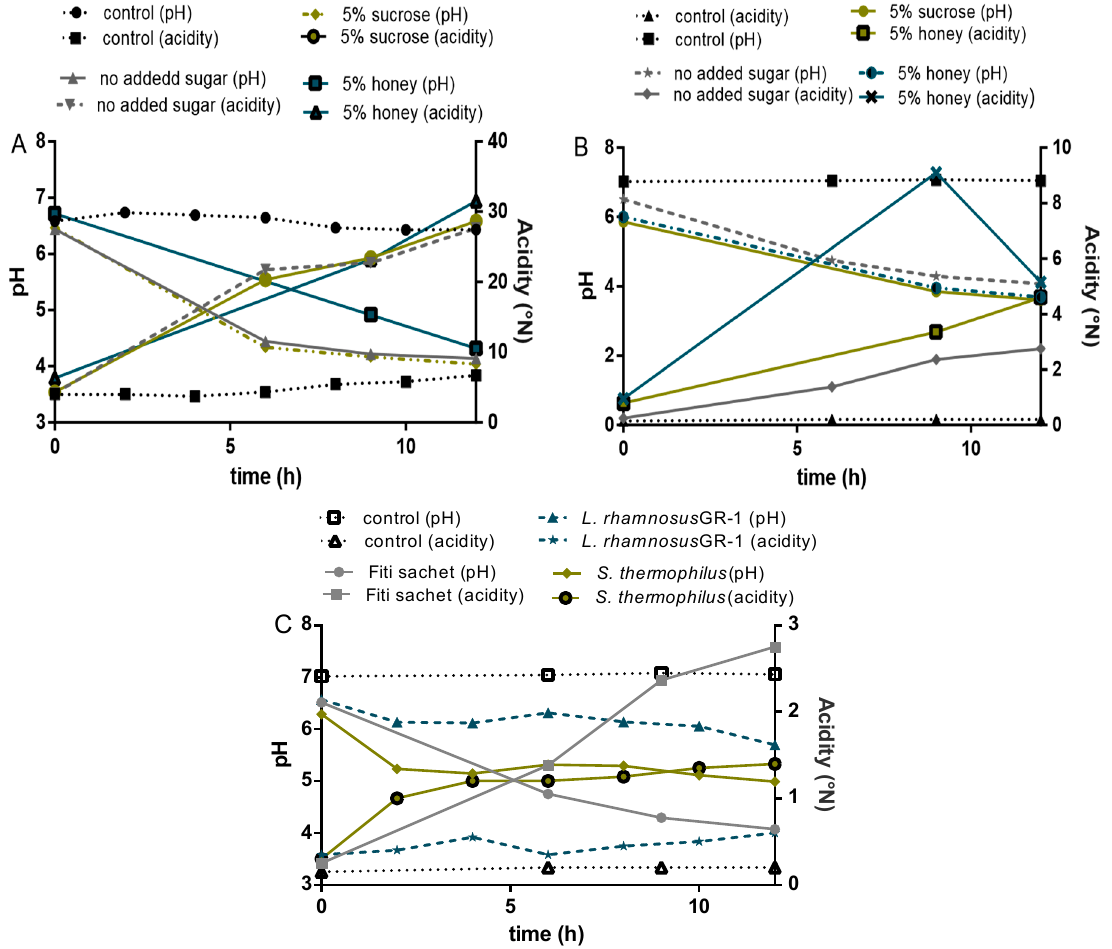
Figure 6. ( a ): 4% millet in milk; (control: milk); ( b ): 8% millet in water; ( c ): single cultures in